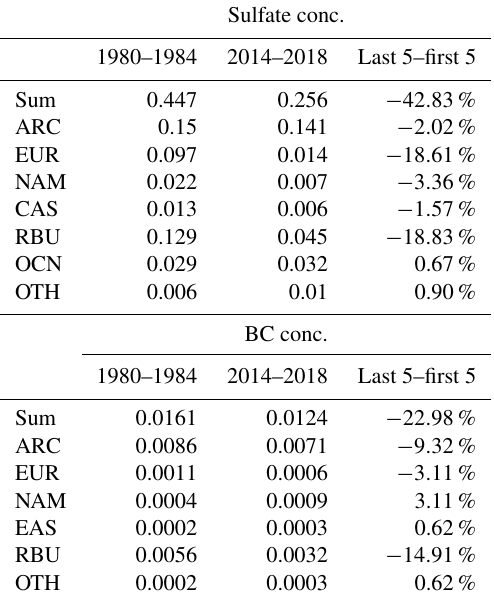
Table 1. Contributions of emissions from major source regions to the simulated annual mean near-surface sulfate and BC concentra- tions (µgm − 3 ) averaged over the Arctic in 1980–1984 and 2014– 2018, as well as the percentage differences (%) between 1980 and 1984 and 2014 and 2018 relative to 1980–1984. Sulfate